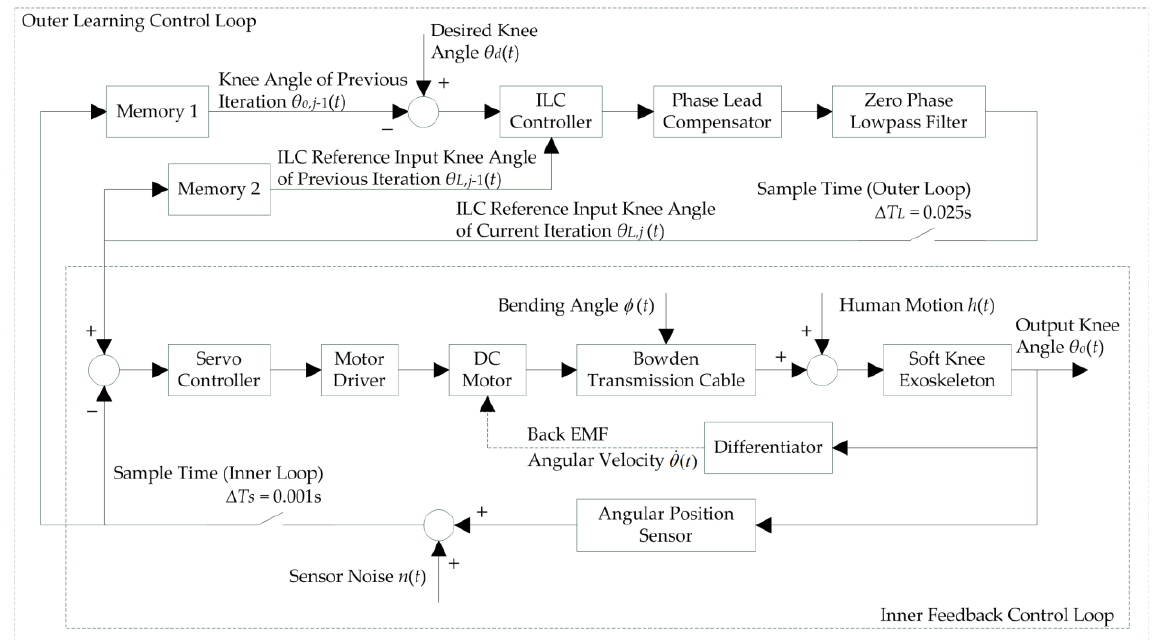
Figure 5. Controller design with an inner stabilizing feedback loop and outer phase-lead ILC loop. The inner loop stabilizes the position control of the soft exoskeleton knee joint, sampling at 1 kHz. The outer loop updates the ILC reference input knee angle iteratively at 40 Hz for the tracking error to converge to zero (or a very small level).